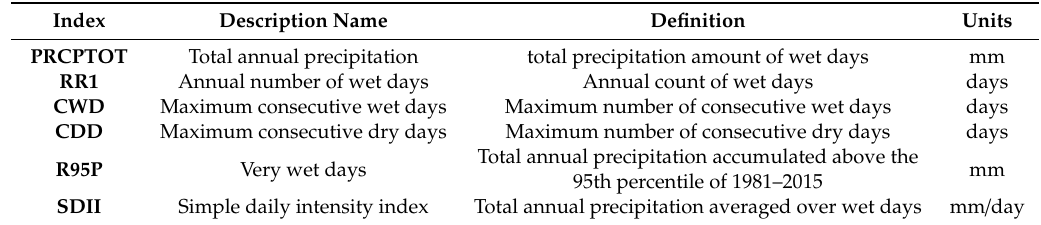
Table 2. Definition of the six Expert Team on Climate Change Detection and Indices (ETCCDI) rainfall-based indices used in the study.